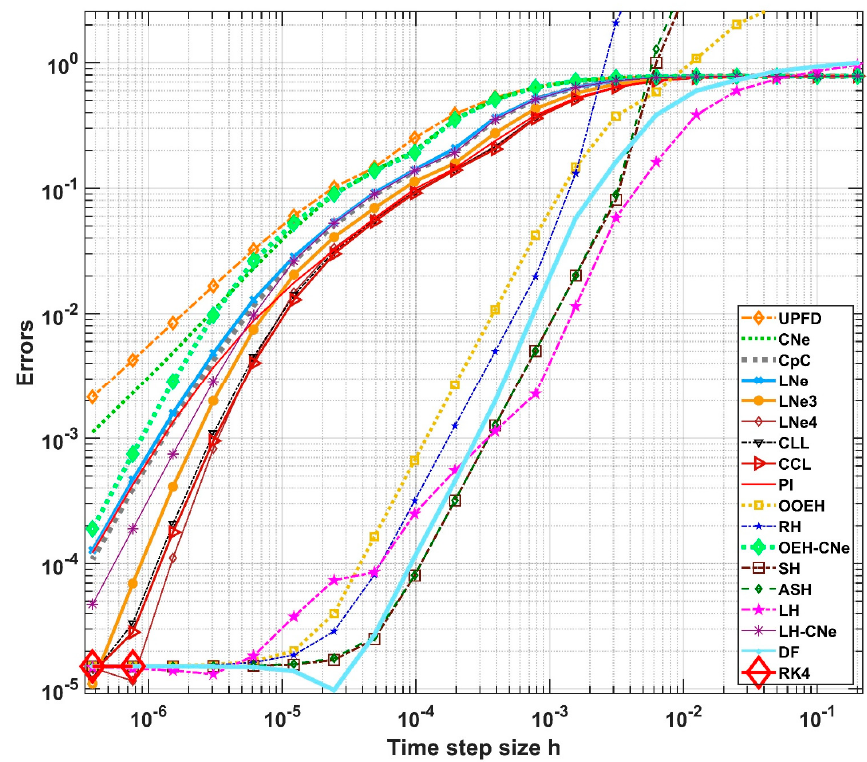
Figure 8. Maximum errors as a function of the time-step size for parameter set (20) (Experiment 2).